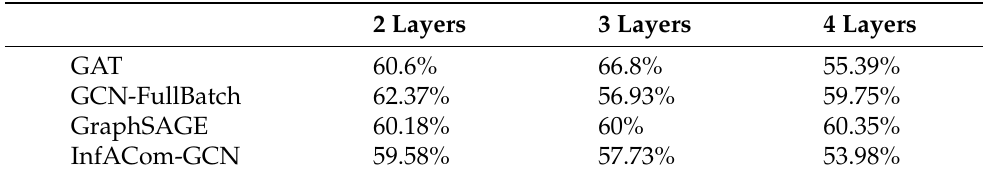
Table 9. Average accuracy of 50 epochs for Citeseer dataset using 2, 3, and 4 layers (the number of hidden units is 128).